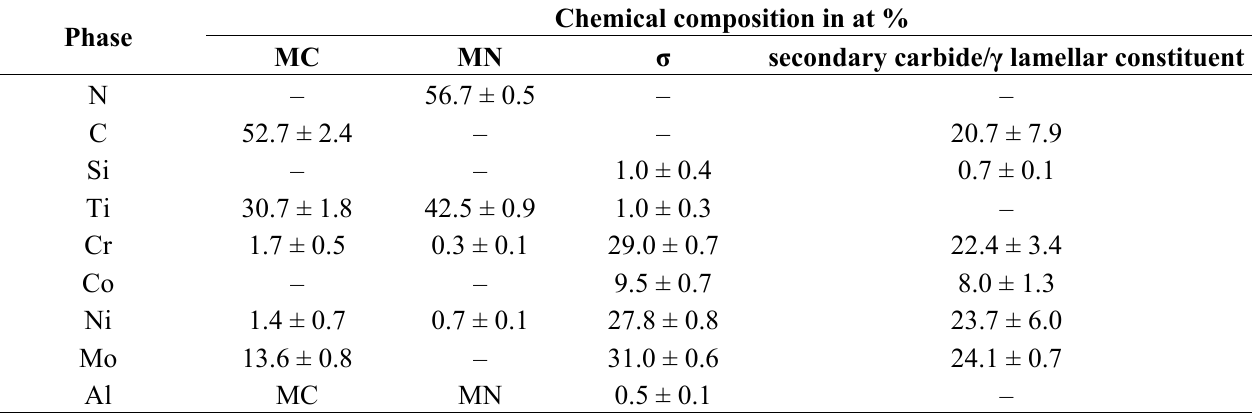
Table 4. Chemical composition in at % of MC, MN, σ and secondary carbide/ γ lamellar constituent as obtained through X-ray spectroscopy (EDS)